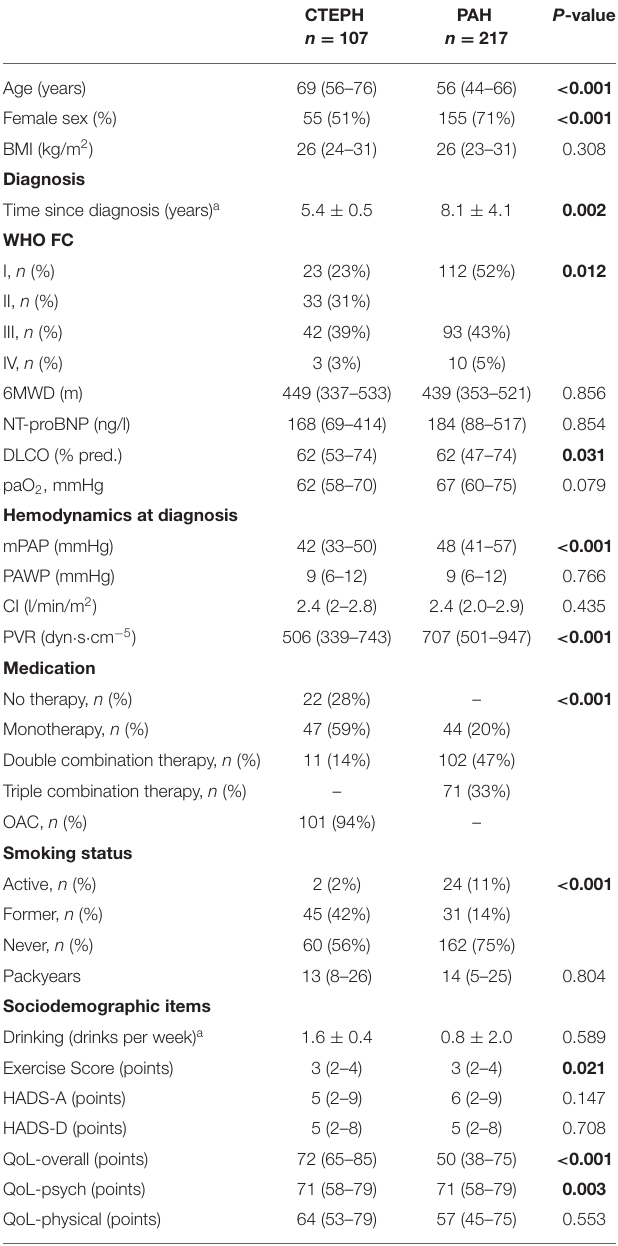
TABLE 1B | Comparison of the characteristics of the CTEPH and PAH patients at baseline.